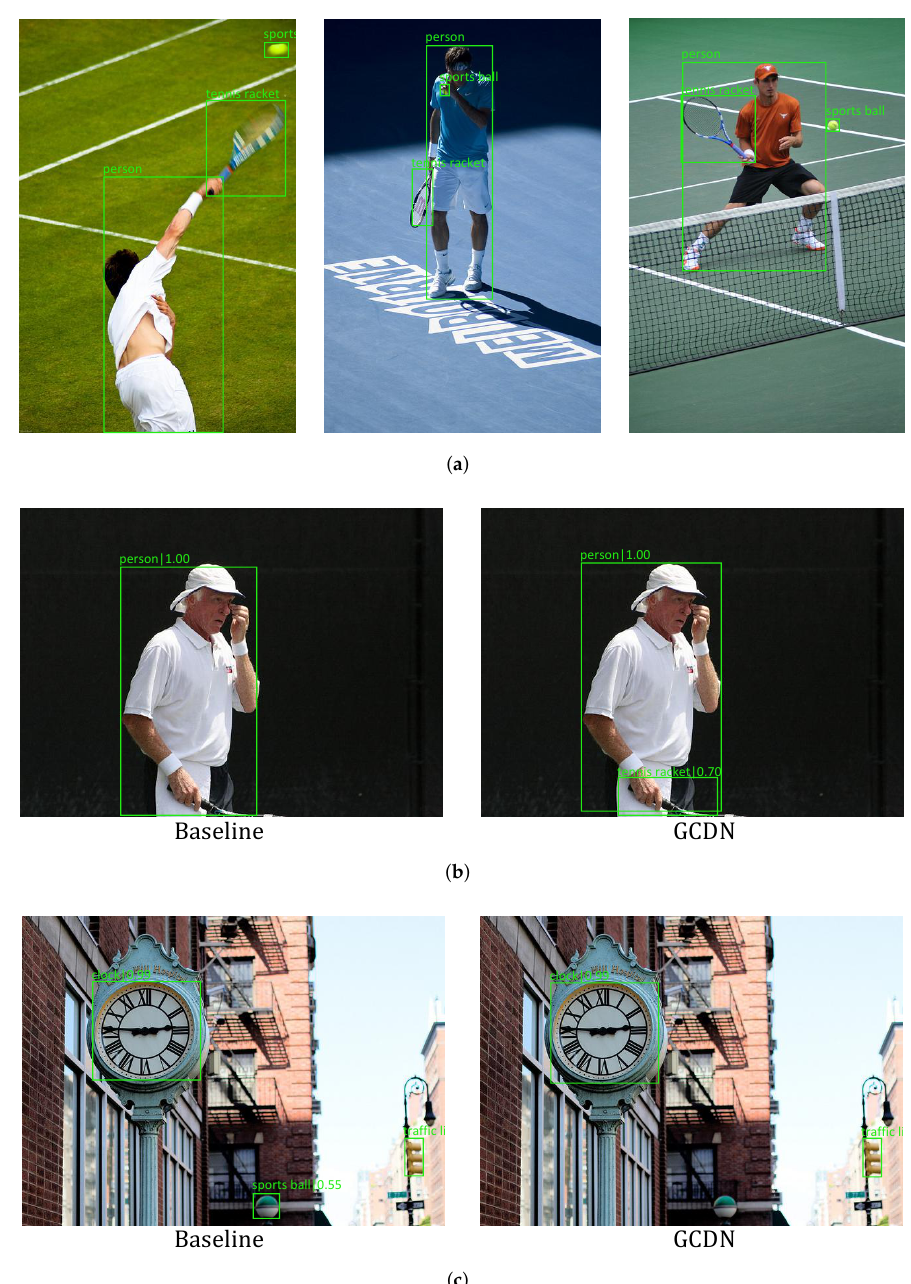
Figure 1. Examples and effects of the context dependencies. ( a ) Person, tennis racket and sports ball often appear together on the tennis court. ( b ) recognizing featureless objects. ( c ) restraining noisy